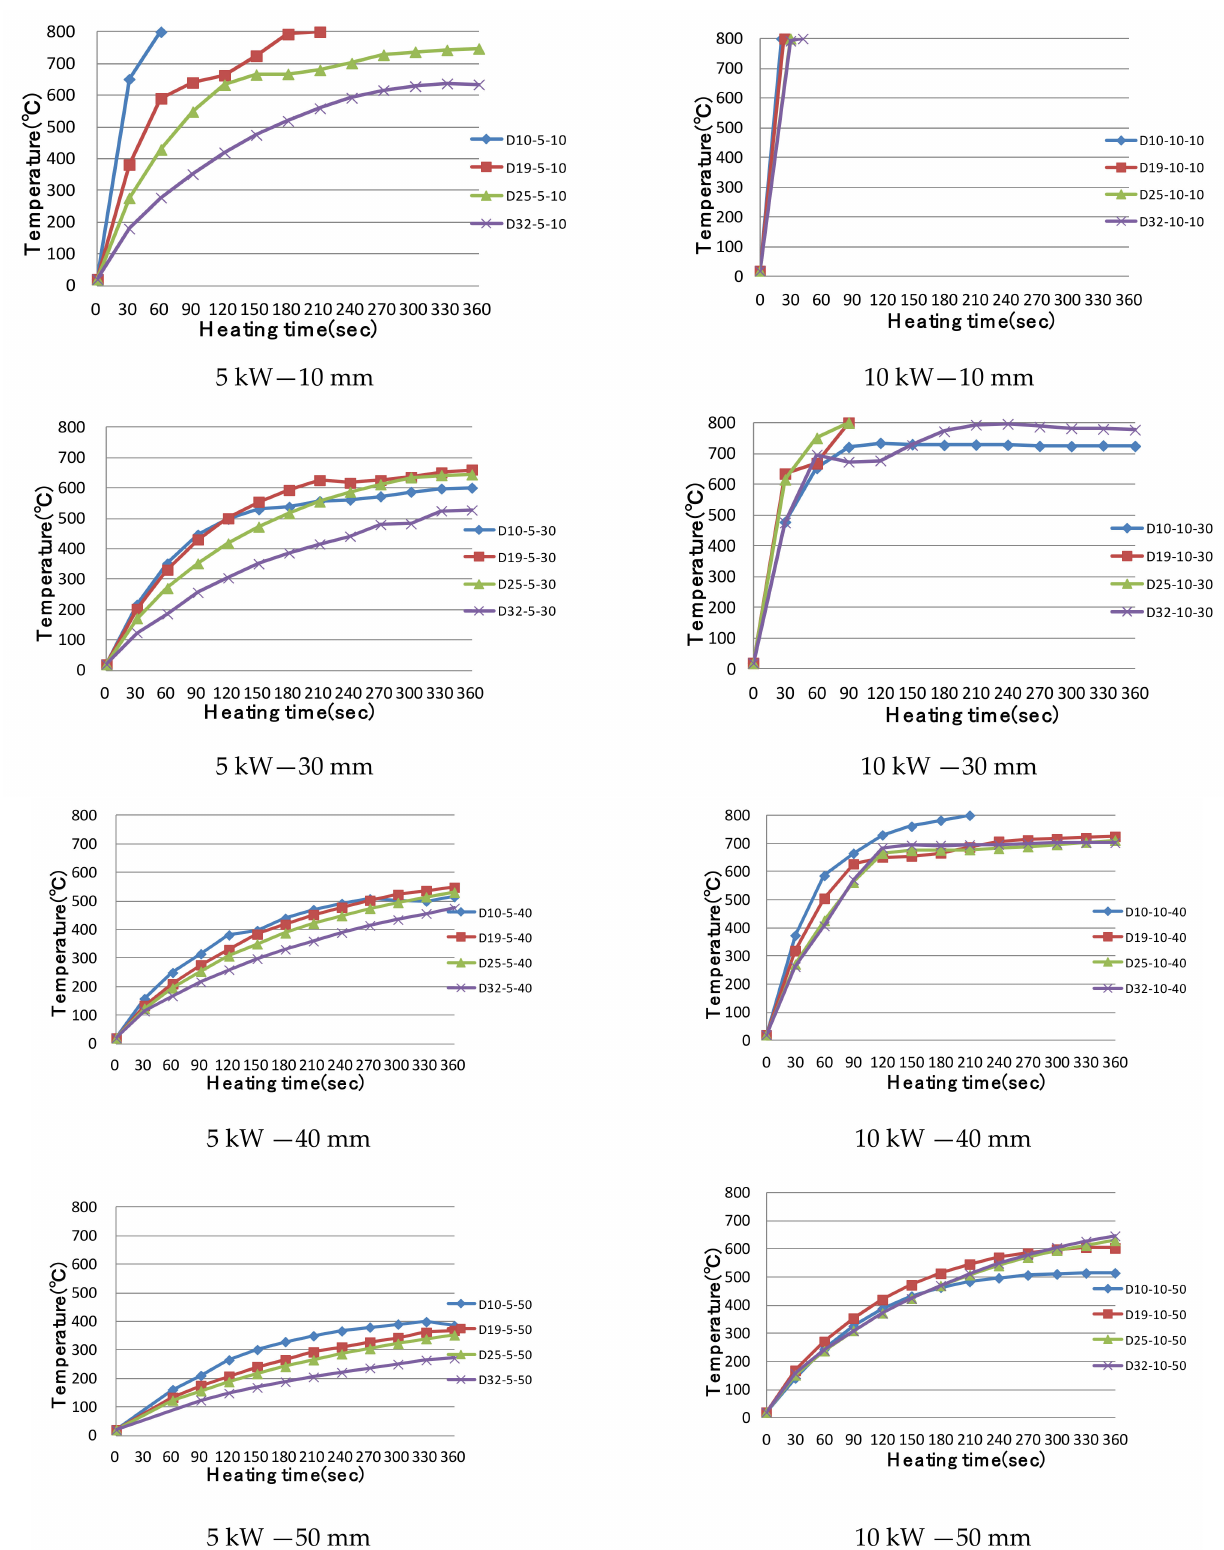
Figure 8. Temperature rise characteristics of rebar during induction heating (430 mm—center). (D00-0-0, D reinforcement type; output, kW; distance,